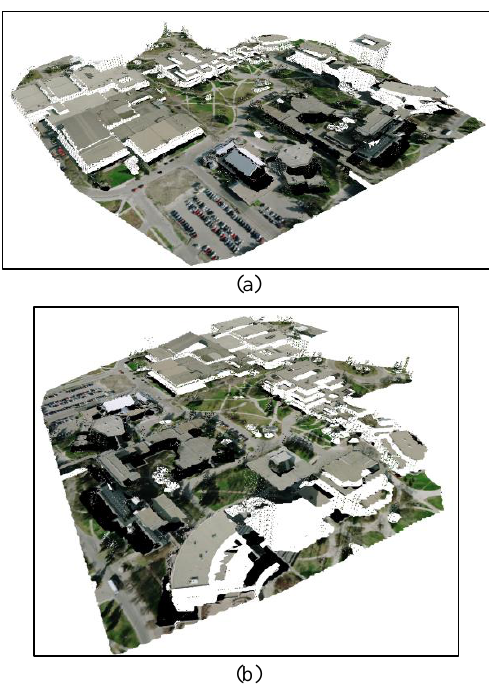
borne imagery have been captured by a GoPro Hero3 Camera. Figure 14 and 15 show different views of photo-textured realistic 3D models generated using the provided multi-platform photogrammetric data.